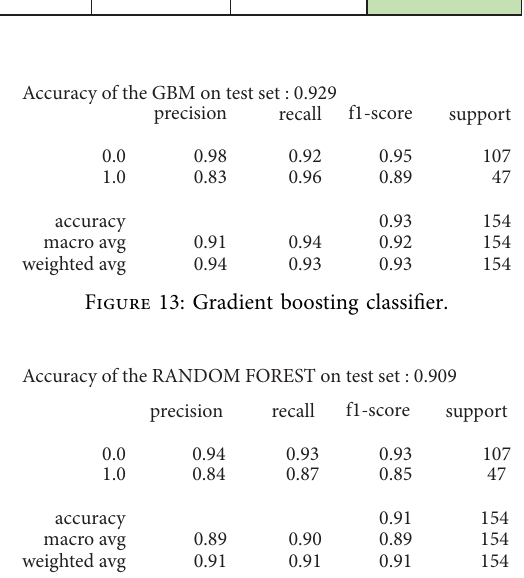
Figure 14: Random forest